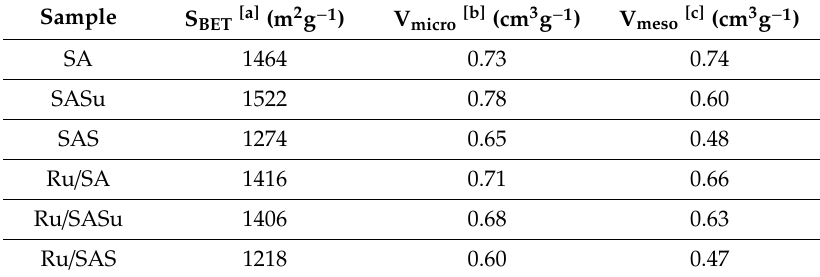
Table 1. Textural parameters determined from N 2 adsorption isotherms (at − 196 °C).